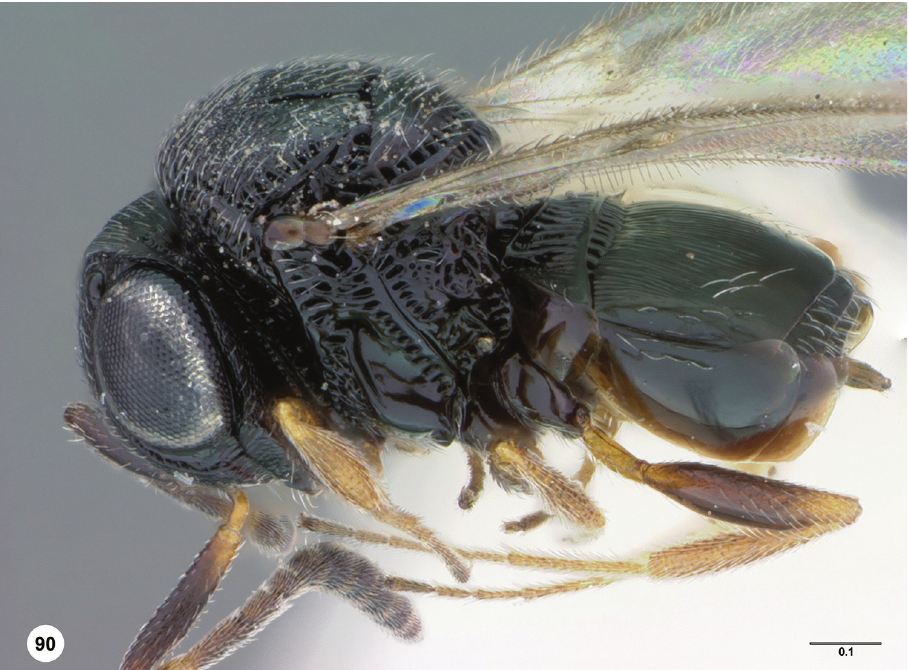
Figure 90. Trissolcus kozlovi , female holotype (ZMAS 0147), head, mesosoma, metasoma, lateral view. Scale bars in